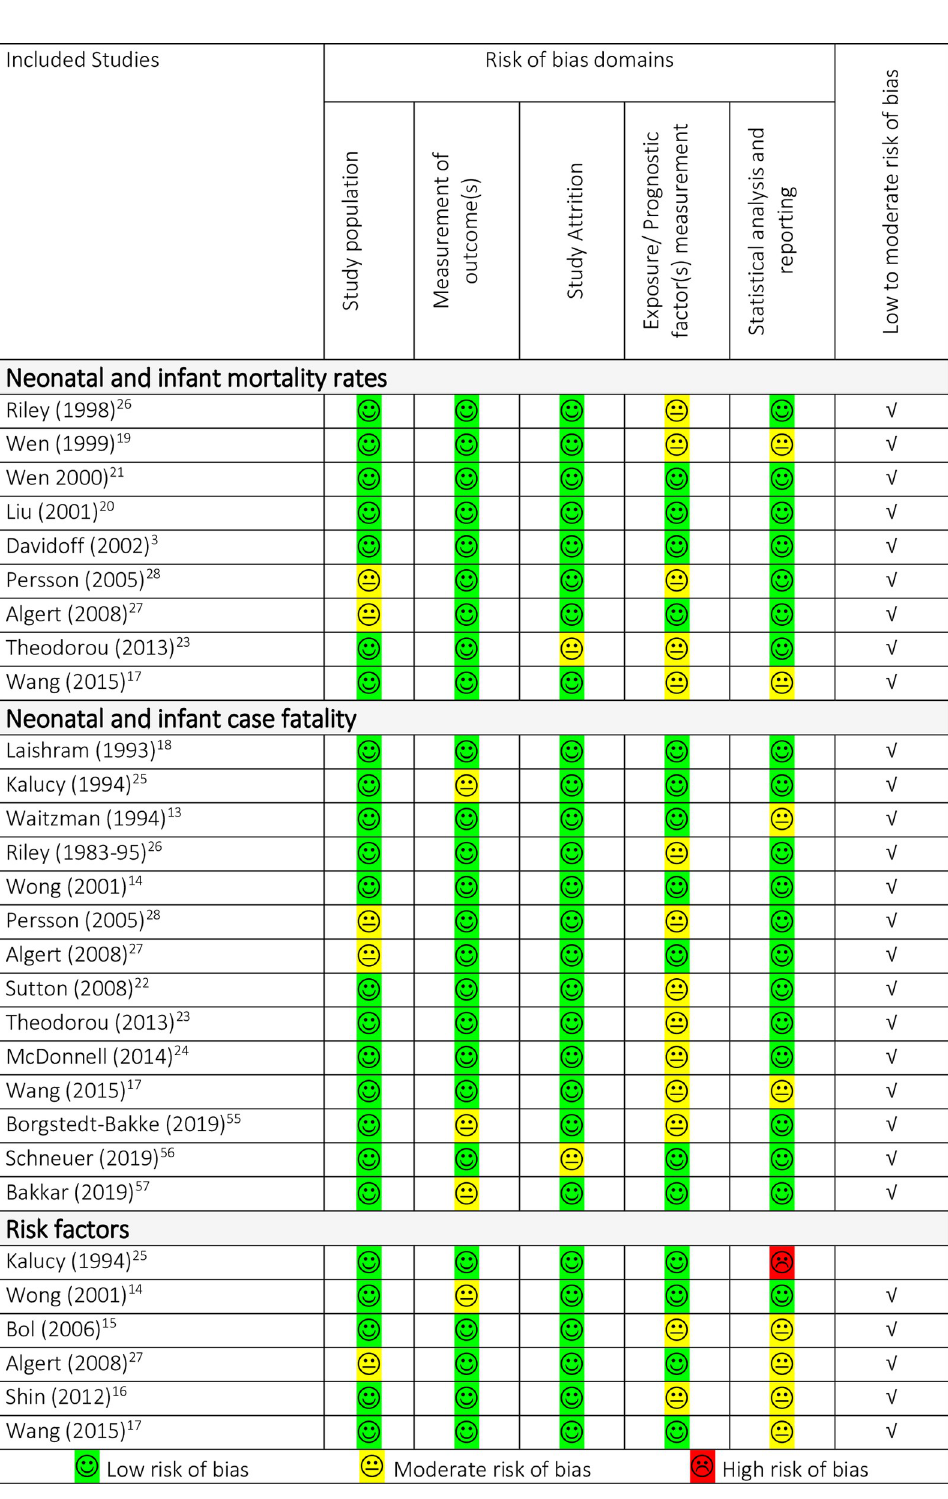
Fig 12. Risk of bias assessment summary table of the included studies.